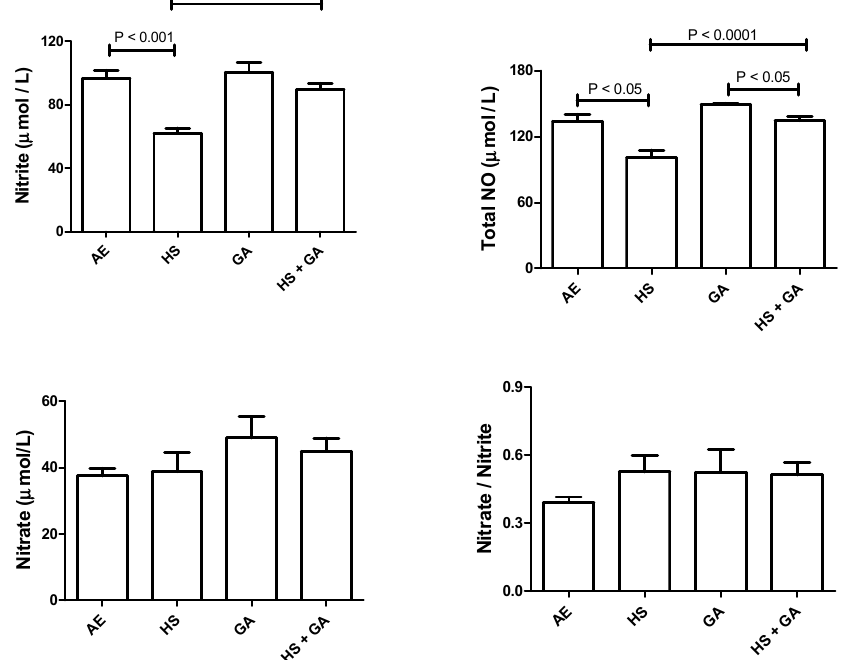
Figure 4. The levels of nitrite, nitrate, total nitric oxide, and nitrate / nitrite in testicular homogenates of mice exposed to normal air (AE) and hookah smoke (HS, 30 min / day) or GA 15% w / v ) with or without exposure to HS. Each vertical column with bar represents the mean ± SEM ( n = 8). The P < 0.05 was considered significant.